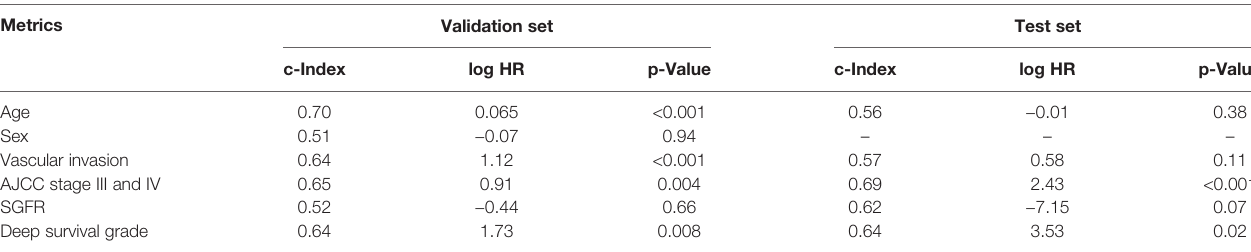
TABLE 2 | Univariable Cox models for each